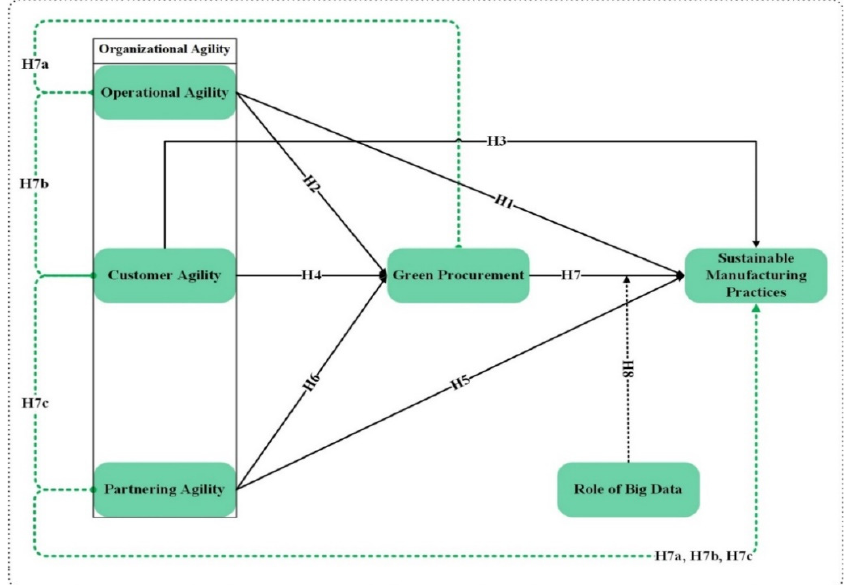
Figure 1. Conceptual Framework.